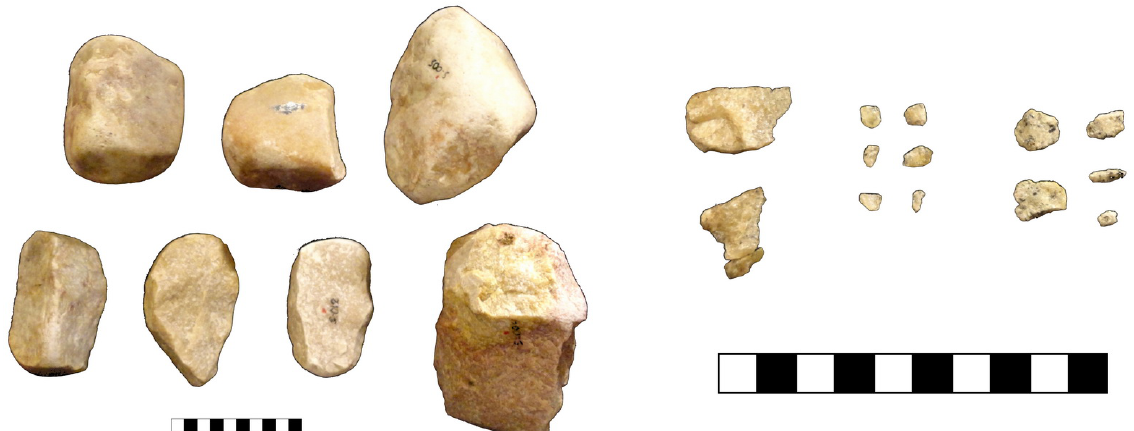
Figure 5. Various impaction tools (L) and different flake types (R). In the former: top row depicts quartzite cobble tools and the bottom row depicts flaked tools. In the latter: quartzite rejuvenation flakes (the bottom of which is refitted; featured in Figure 3), quartzite impaction use-flakes, and cortical granite fragments are depicted, respectively. Scale bar = 10